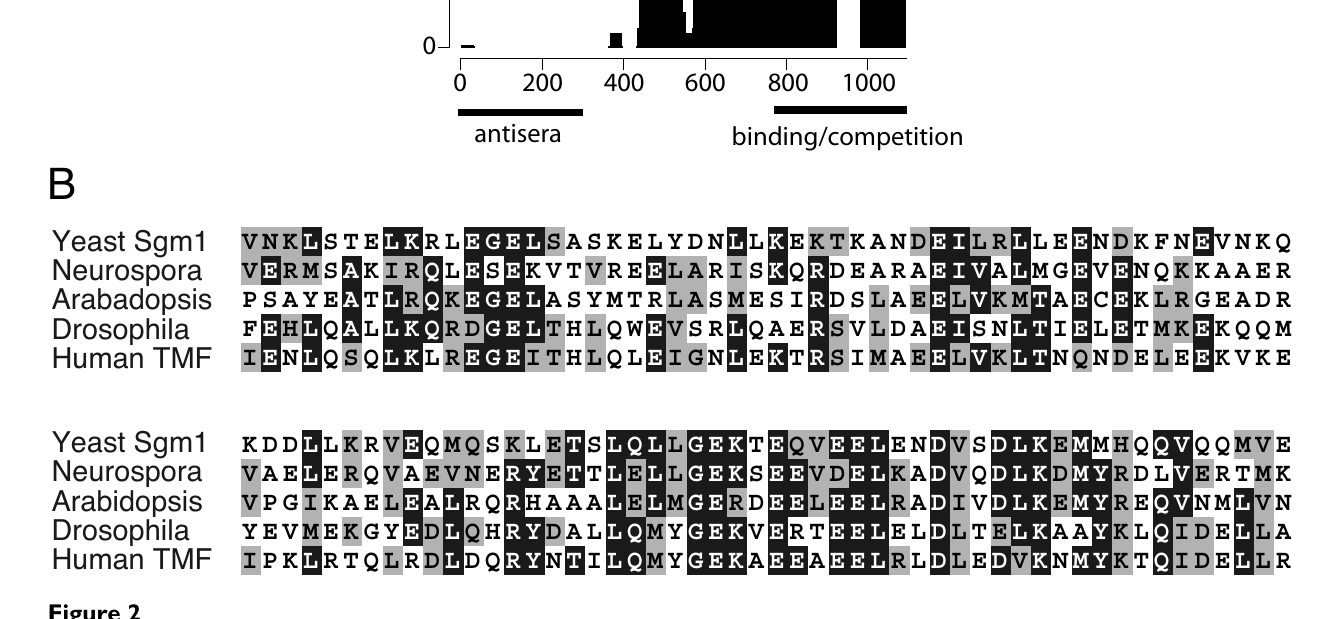
Figure 2 Sgm1 homologues are present in a wide range of eukaryotes A. Coiled-coil predictions for various Sgm1-like proteins. Note that each has a distinct 100-residue coiled-coil domain at the C terminus, which in Sgm1 corresponds to the Ypt6-binding domain. The regions of TMF used for binding and antibody production are indicated by lines. The accession numbers for the uncharacterised proteins shown are: Neurospora, CAB97305; Arabidopsis, C96829; Drosophila AAF46211. B. Sequence align- ment of the C-terminal coiled coil domains of the proteins depicted in